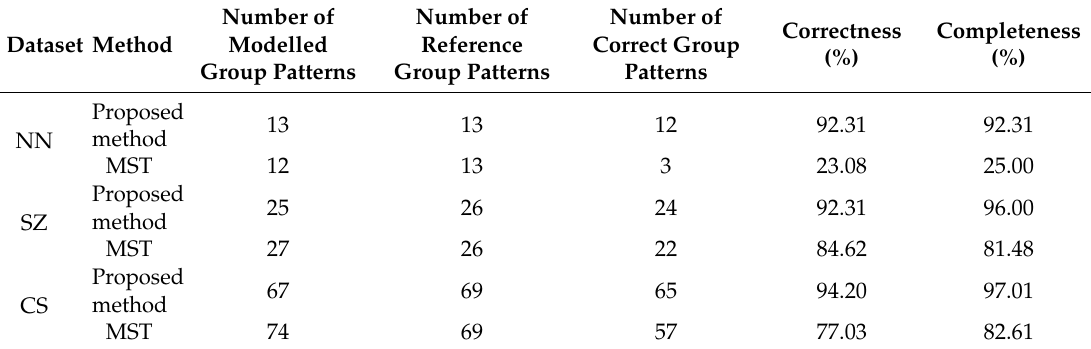
Table 2. The accuracy of linear building pattern recognition.